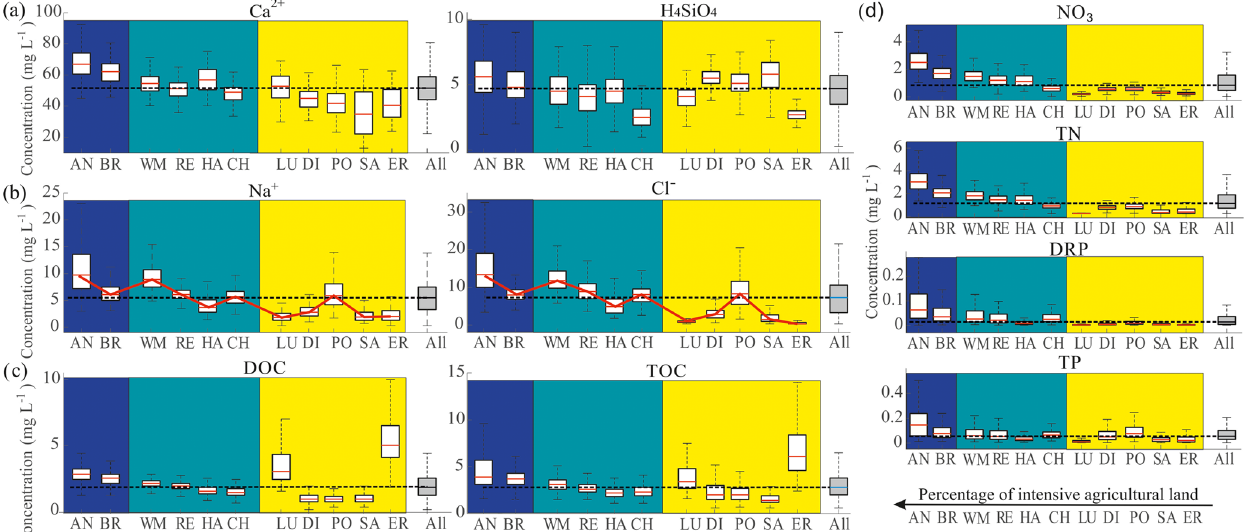
Figure 3. Box plot of measured concentrations across catchments. The grey box on the right of each subplot refers to the concentrations computed from all the observations of all the catchments. The black horizontal dashed line represents the median of all the measurements across all the catchments. (a) shows the effect of bedrock geological composition on Ca 2 + and H 4 SiO 4 concentrations. (b) shows the pattern of Na + and Cl − concentrations across catchments. (c) shows the DOC and TOC concentrations. (d) shows the decreasing trend of the nutrients’ median concentrations. The catchments are ordered by increasing percentage of land used for intensive agriculture, as shown in the bottom table, and the background colors refer to the catchment classes: Swiss Plateau (blue), hybrid (light blue), and Alpine (yellow)